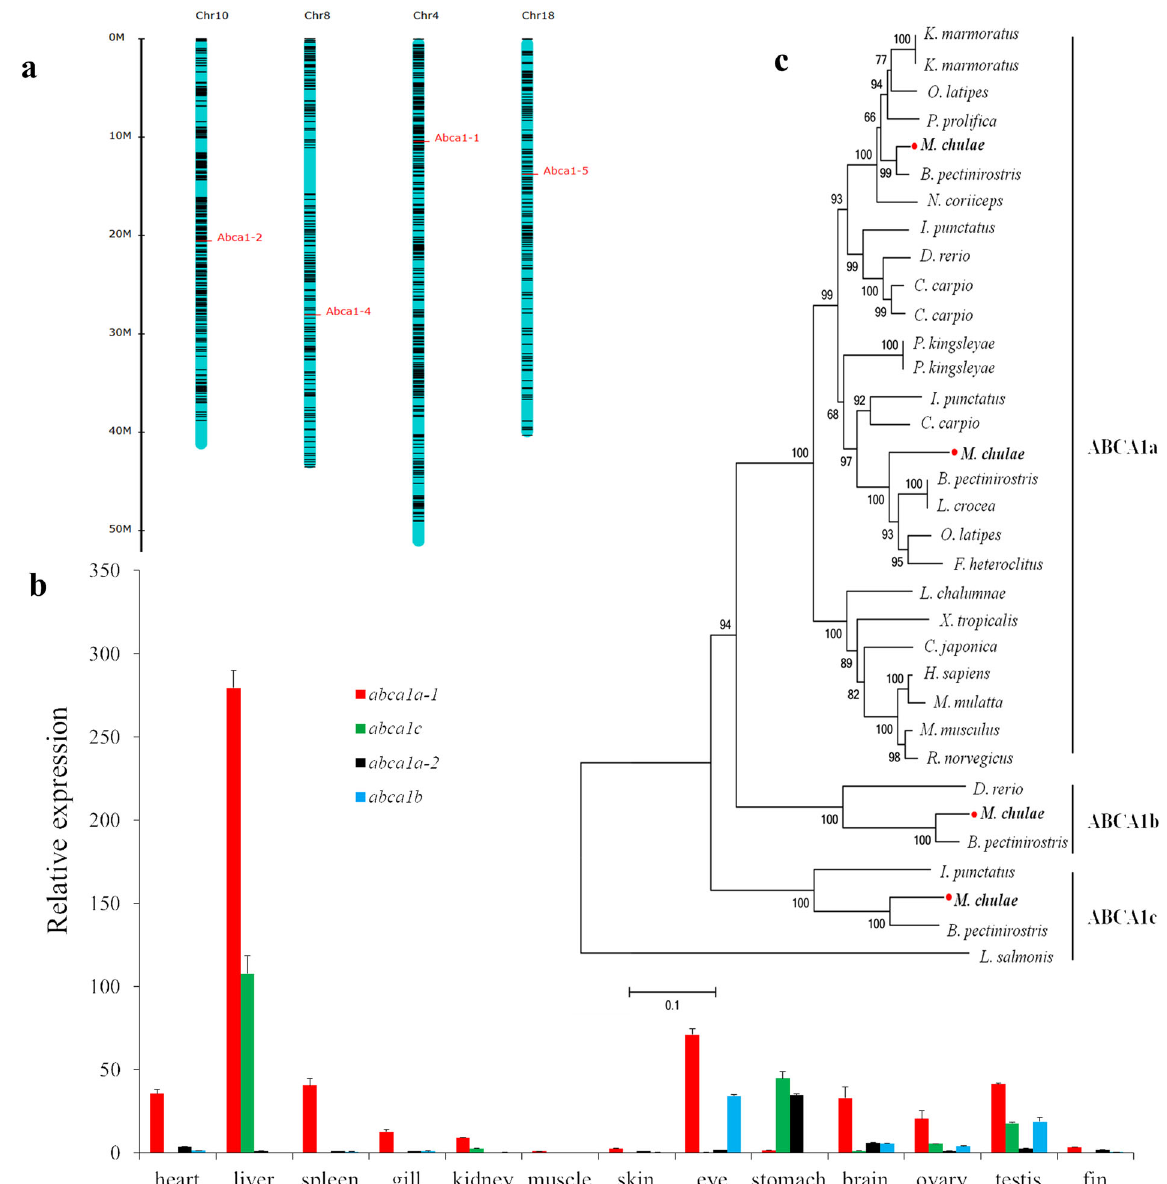
Fig. 4 Structure and expression analysis of ABCA1 in yellowstripe goby. a Chromosomal location of ABCA1 genes. b The relative expression of ABCA1 genes in 13 tissues ( n = 3 biologically independent tissue samples). c Phylogenetic tree of ABCA1 between yellowstripe goby and other representative